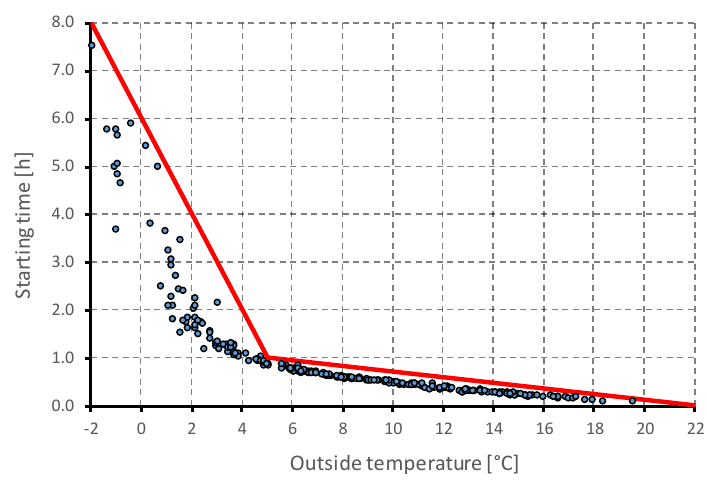
Figure 15. Time required to reach the setpoint temperature.